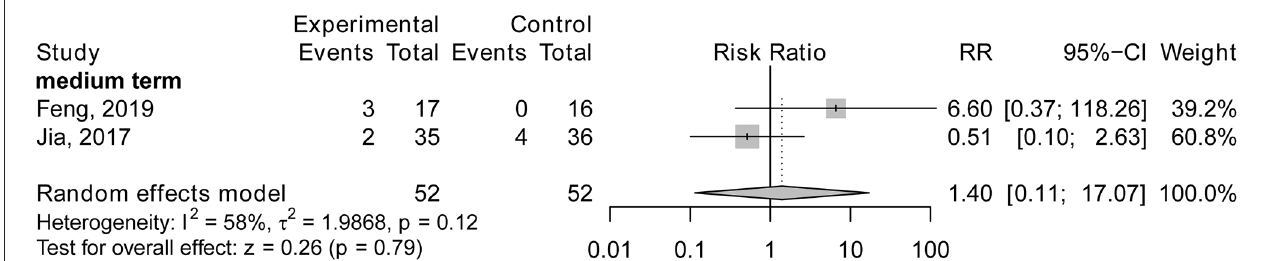
FIGURE 13 | The forest plot of incidence of adverse events of acupuncture vs. drug therapy.